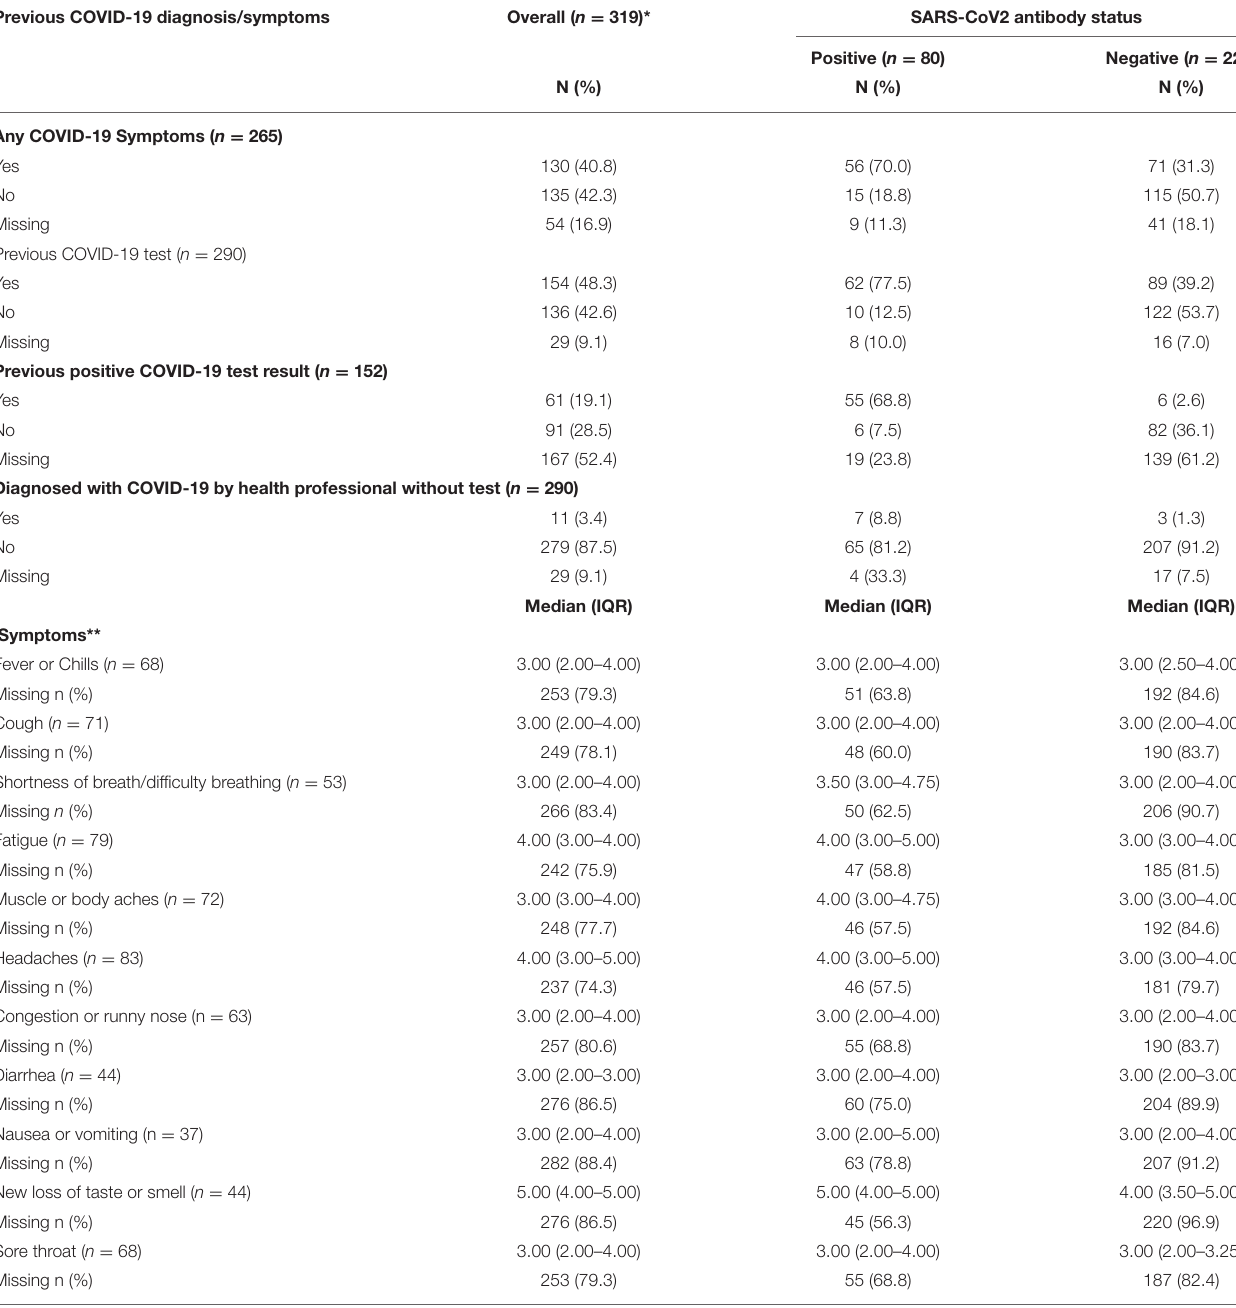
TABLE 3 | SARS-CoV2 symptoms and previous diagnosis, TX CARES, all phase 1 participants, 2020. Previous COVID-19